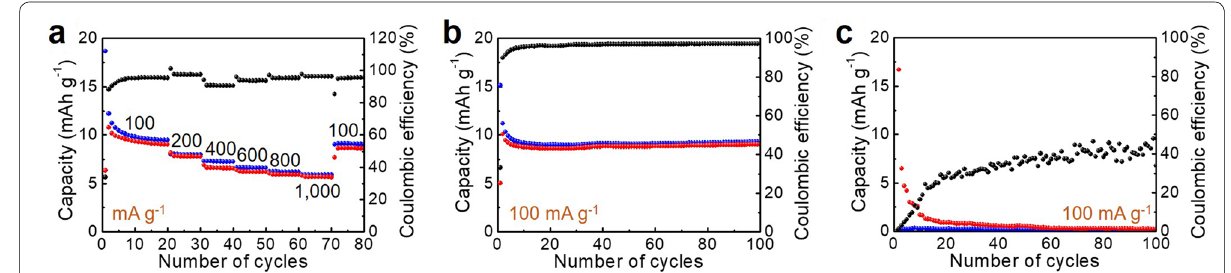
Fig. 1 a Rate performance and b repeated charge/discharge properties of the SC as a cathode material of LIBs. c Repeated charge/discharge performance of SC as a cathode material of